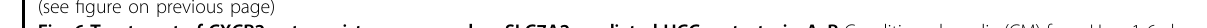
Table S5. Lentiviral vectors encoding the human SLC7A2 genes and mouse SLC7A2 genes were constructed in PLKO.1-puro (Hanbio, Shanghai, China) and designated as LV-SLC7A2. An empty vector was used as the negative control and was designated as LV-control. Concentrated